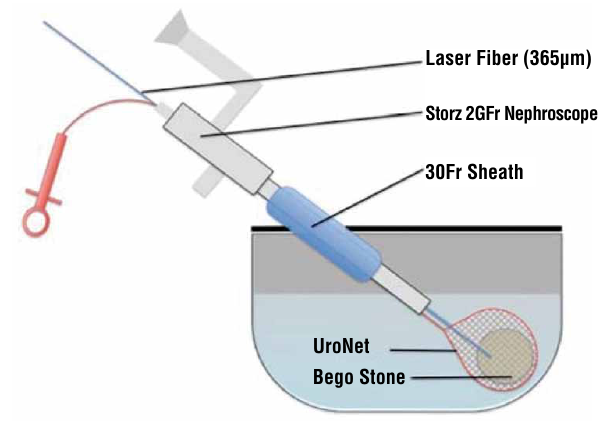
Figure 1 - Schematic view of ho:YAG laser lithotripsy with the uro-Net stone entrapment device during percutaneous nephrolithotomy and cystolithopaxy.